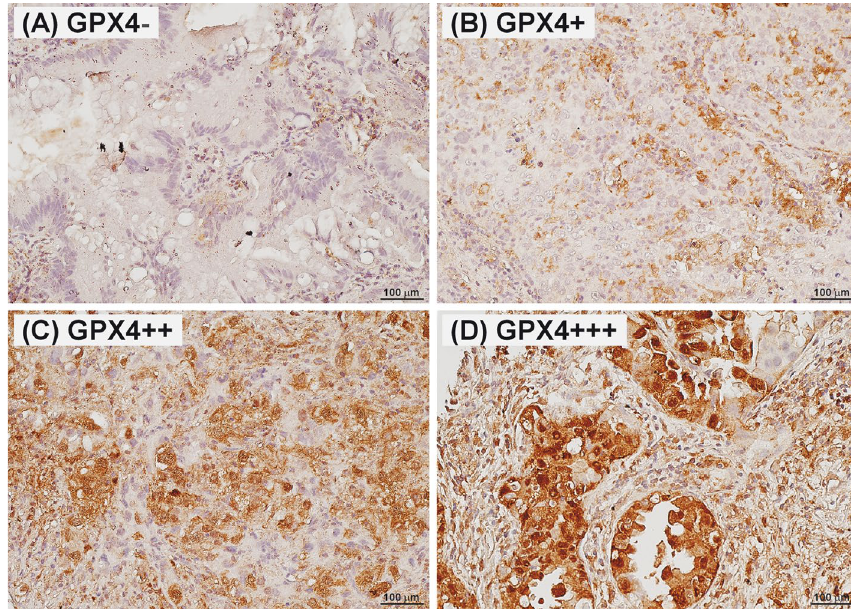
Figure 1. Immunohistochemical staining patterns of glutathione peroxidase 4 (GPX4) in resected non-small cell lung cancer specimens (original magnification × 400). Expression was marked and is shown in the left upper corner of each photograph as “GPX4−” if less than 5% of cells were positive ( A ), as “GPX4+” if 5–25% of cells were positive ( B ), as “GPX4++” if 25–75% of cells were positive ( C ), and as “GPX+++” if more than 75% of cells were positive ( D ) in the microscopic